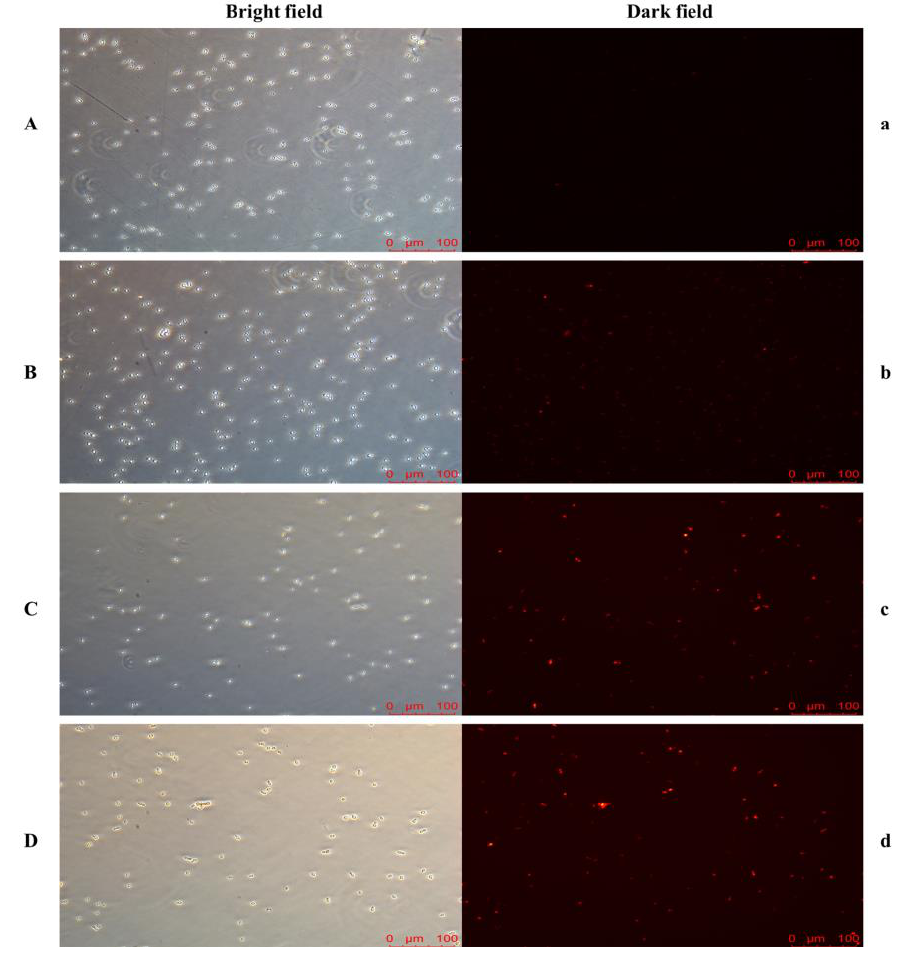
Figure 4. The PI staining results of P. anomala NCU003 under different ethanol stress concentrations (( A ), ( a ): control; ( B ), ( b ): 3% ethanol; ( C ), ( c ): 6% ethanol; ( D ), ( d ): 9% ethanol).